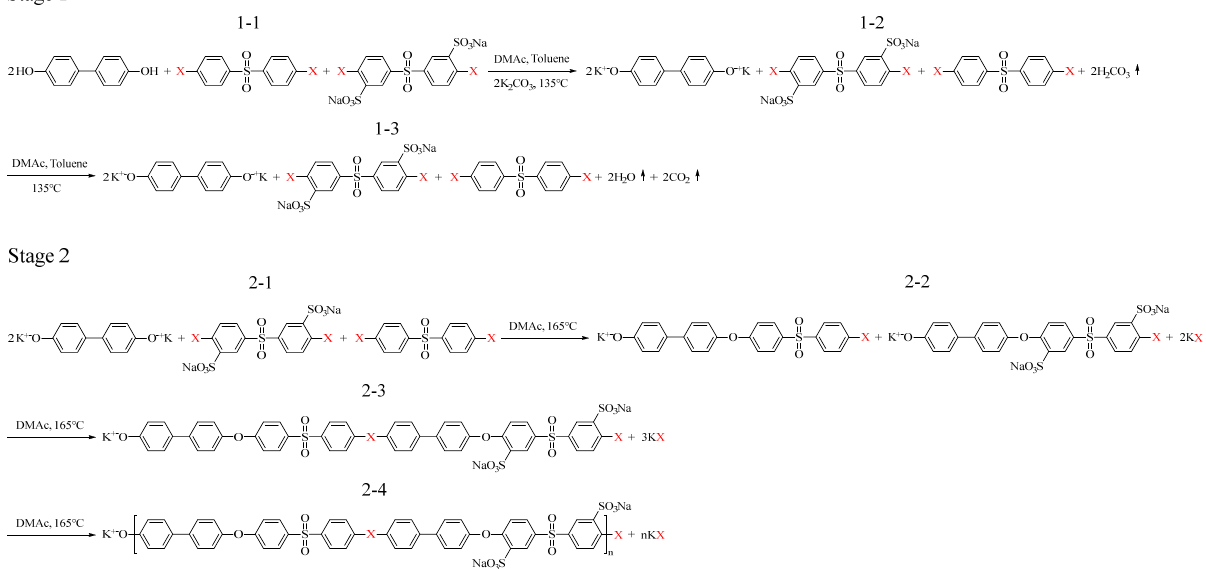
Figure 5. Synthesis steps for SPAES polymerization.